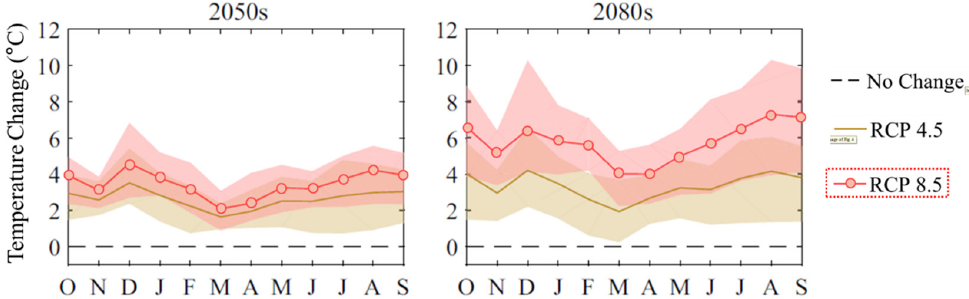
Figure 1. Monthly projected changes in the outdoor air temperature [24]. RCP: Representative concentration pathways.